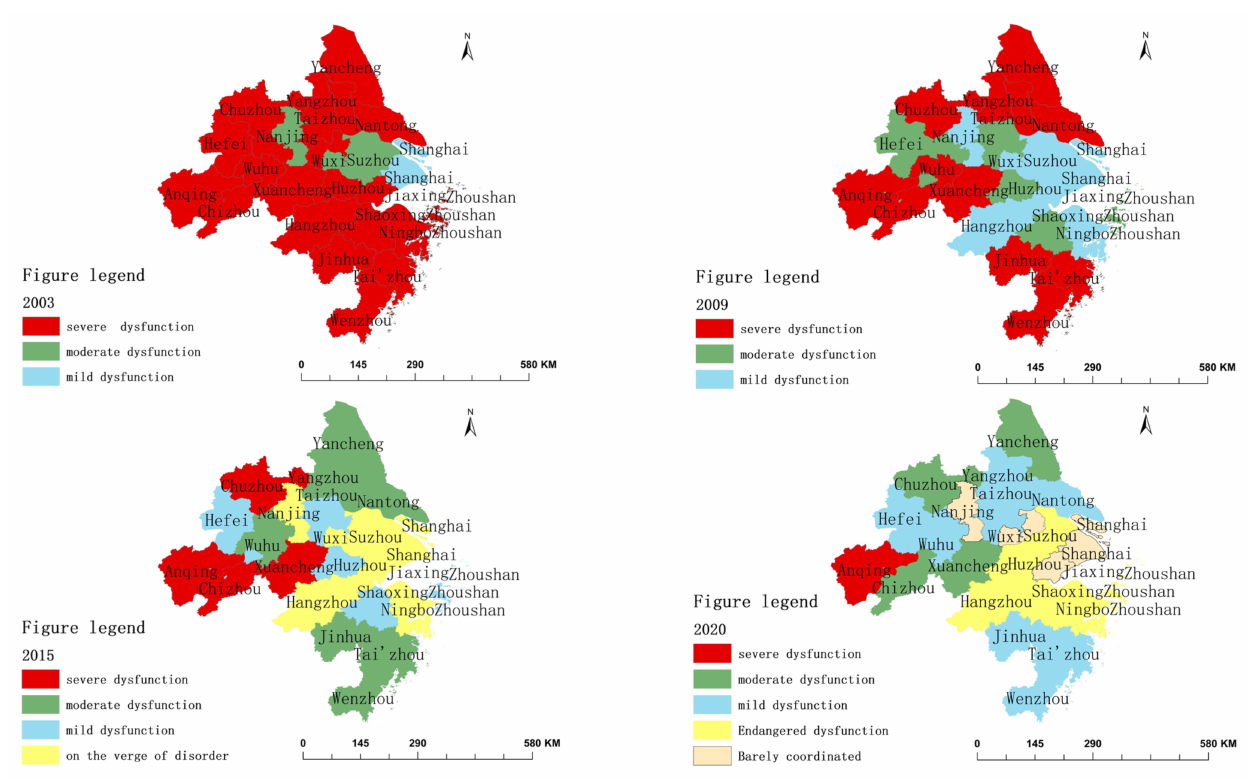
Figure 4. Spatial distribution of urban-rural integration development in the central cities of the Yangtze River Delta